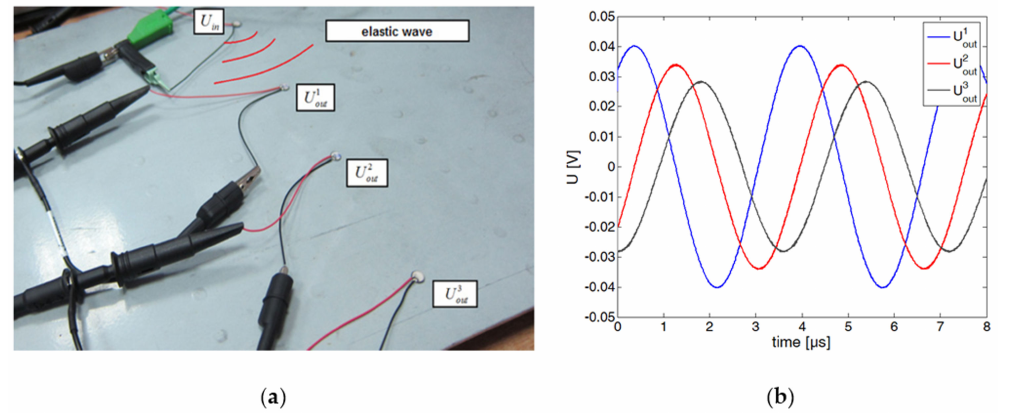
Figure 2. Example of a sinusoidal steady state excitation of PZT sensors: ( a ) PZT network; ( b ) Output voltages acquired on PZT sensors.